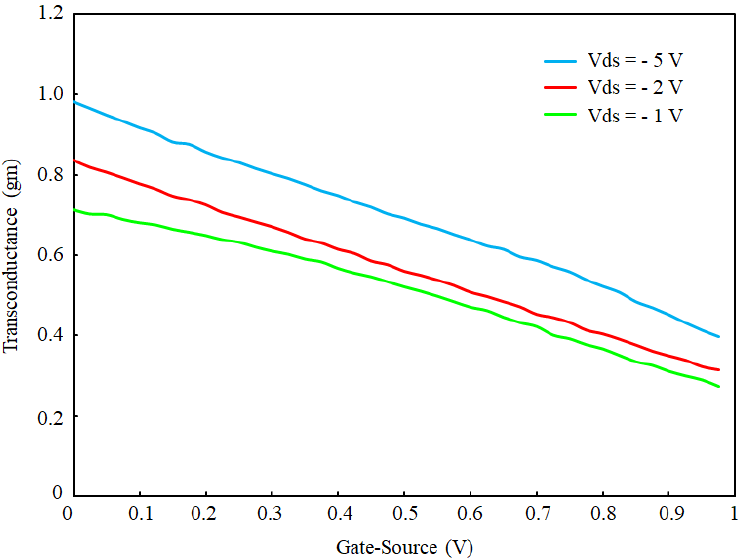
Figure 9. Change of conductance of OG ‐ JFET with back gate.